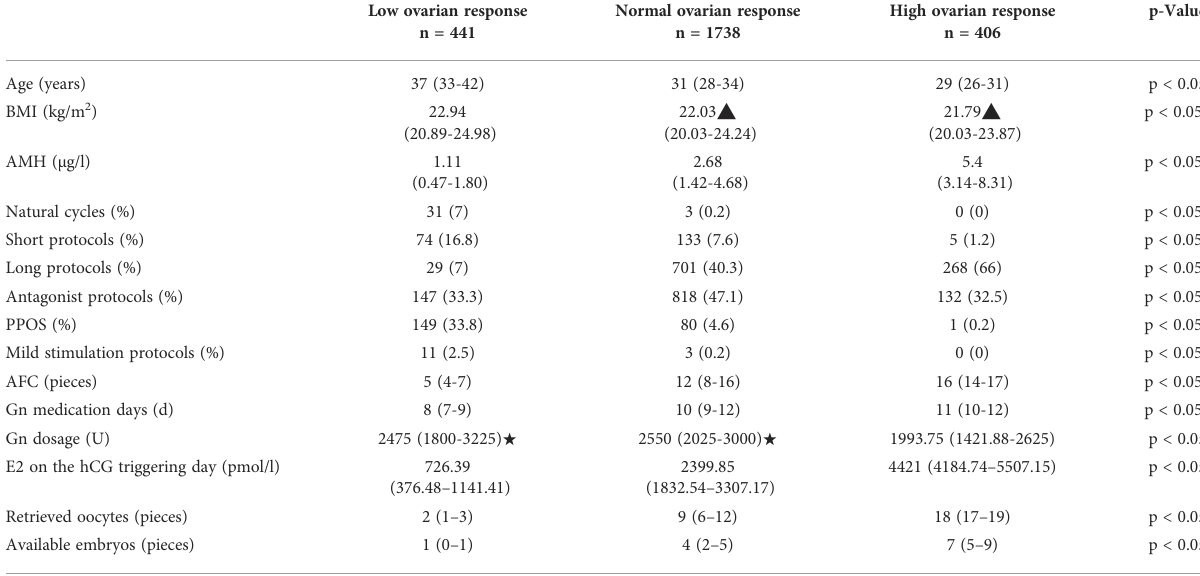
TABLE 1 Comparison of conditions in different ovarian response